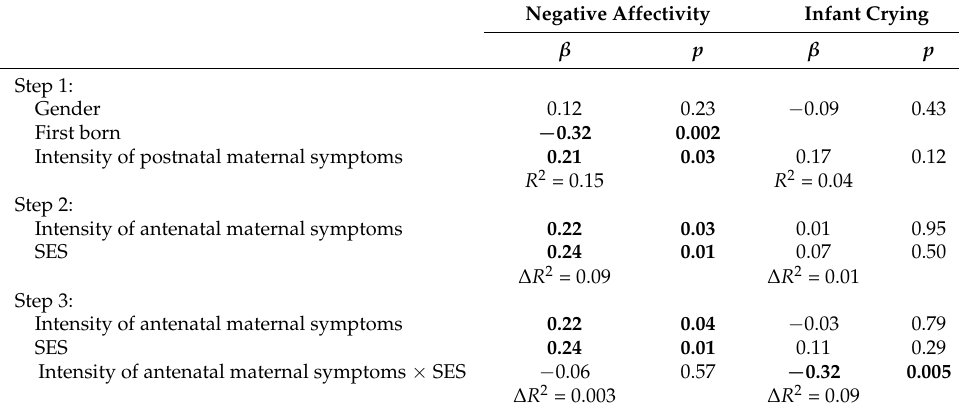
Bold values indicate significant p < 0.05 results. SES: socioeconomic